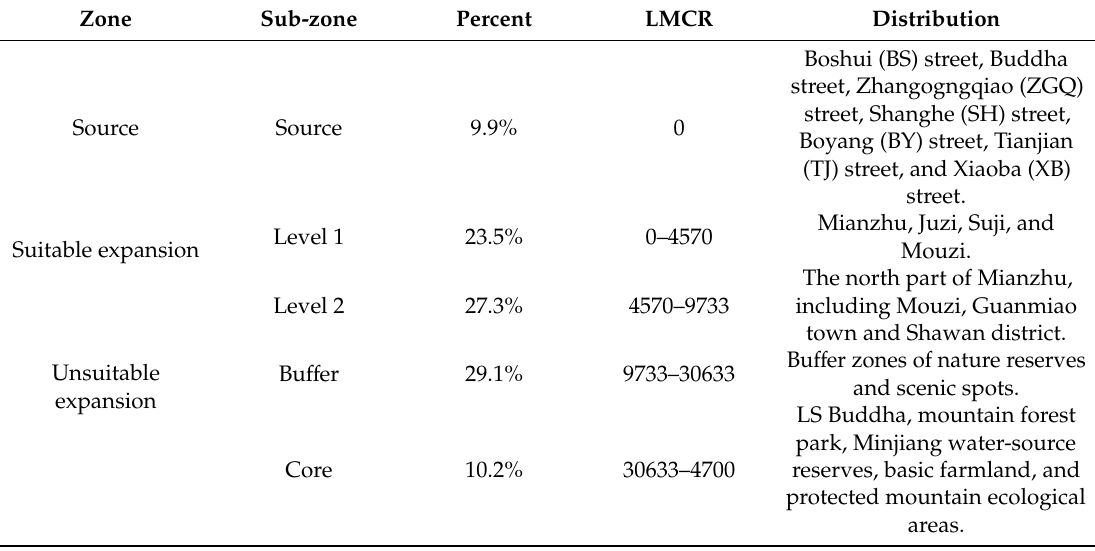
Figure 9. Overlay layers of the LMCR surface, eco-barrier, and RF surfaces. Table 3. Suitability zoning and corresponding basic